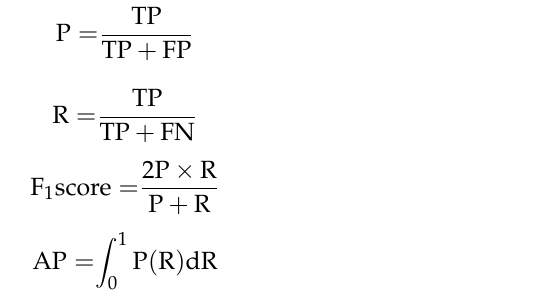
Table 2. Training parameters.